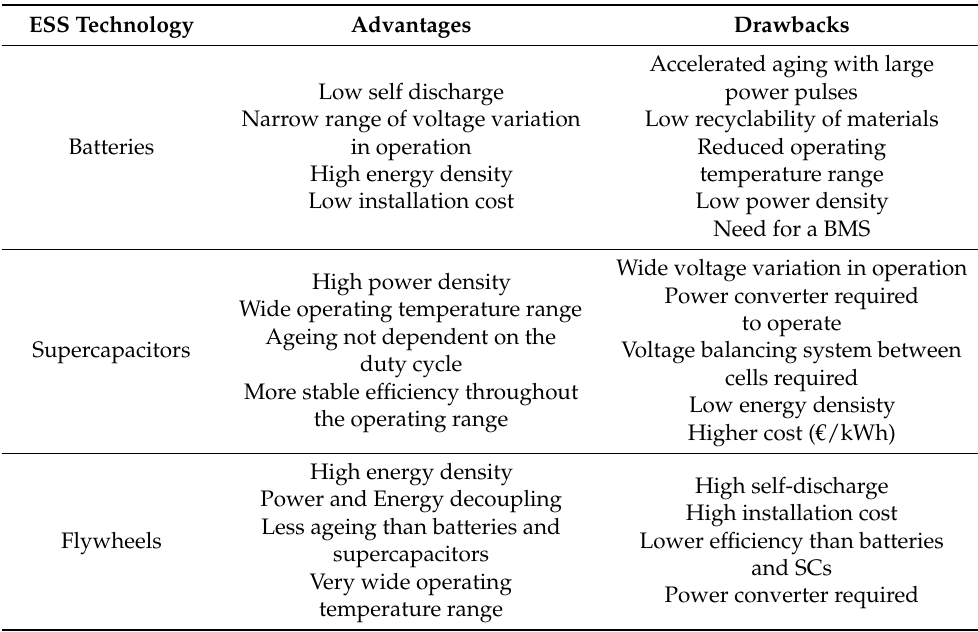
Table 3. Comparison based on benefits and drawbacks of the Batteries, flywheels and Supercapacitors. ESS